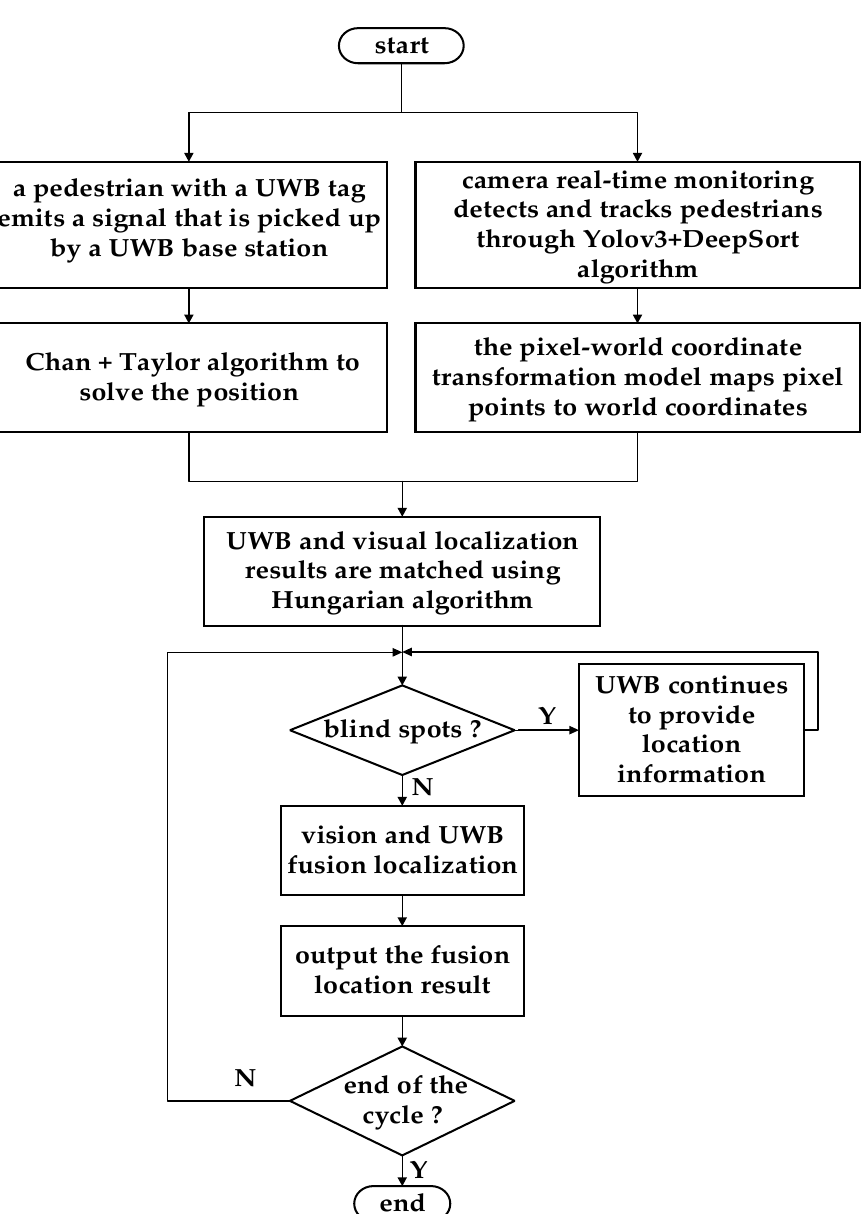
Figure 5. Flowchart of the fusion location algorithm model.